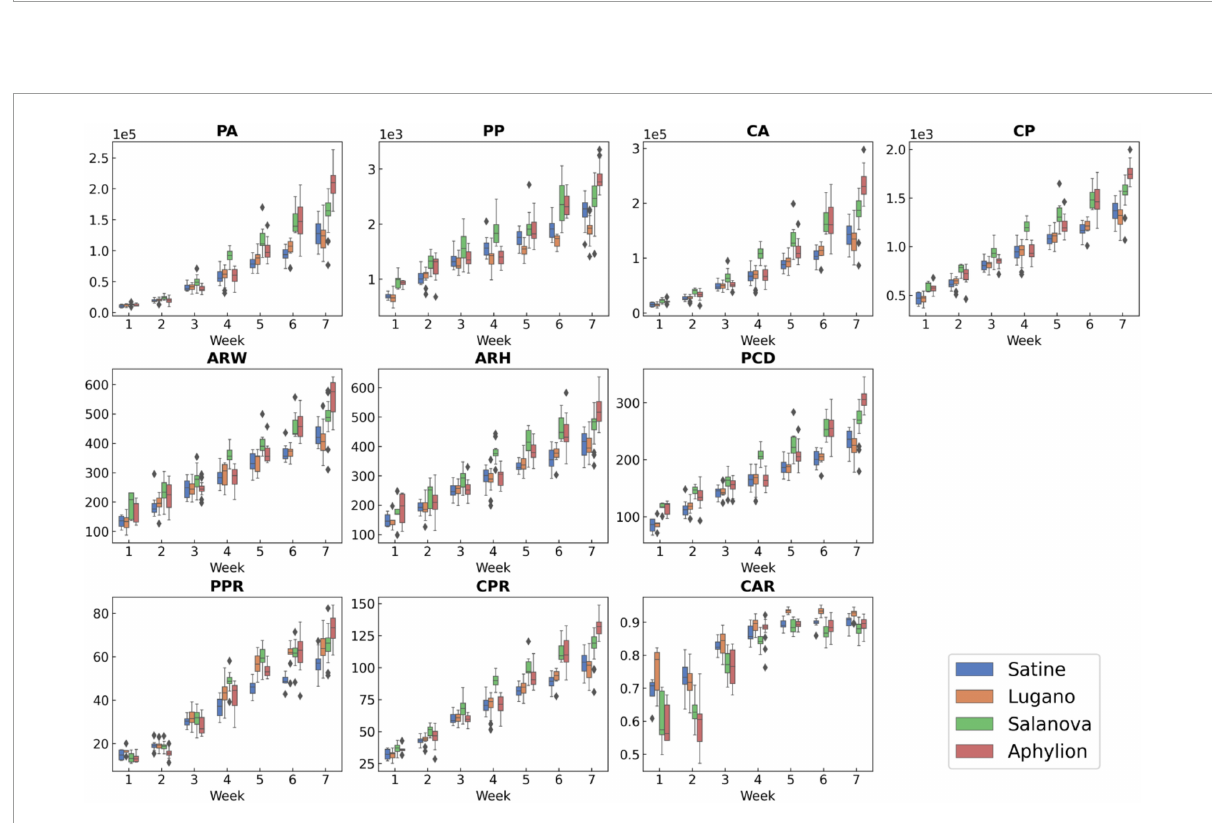
FIGURE6 Data distribution of extracted geometric traits of the four lettuce varieties in 7